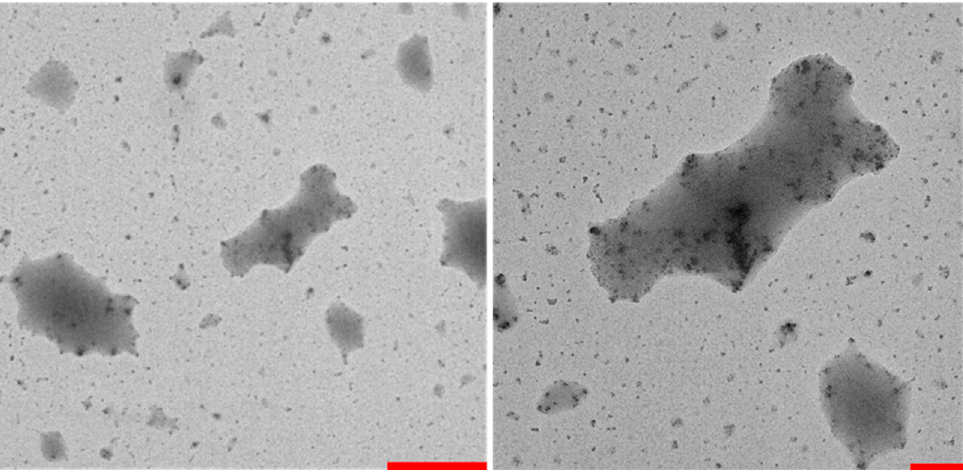
Figure 7. TEM images of the StarP thin film: ( left ), scale bar corresponds to 2 µm; ( right ), scale bar corresponds to 500 nm.